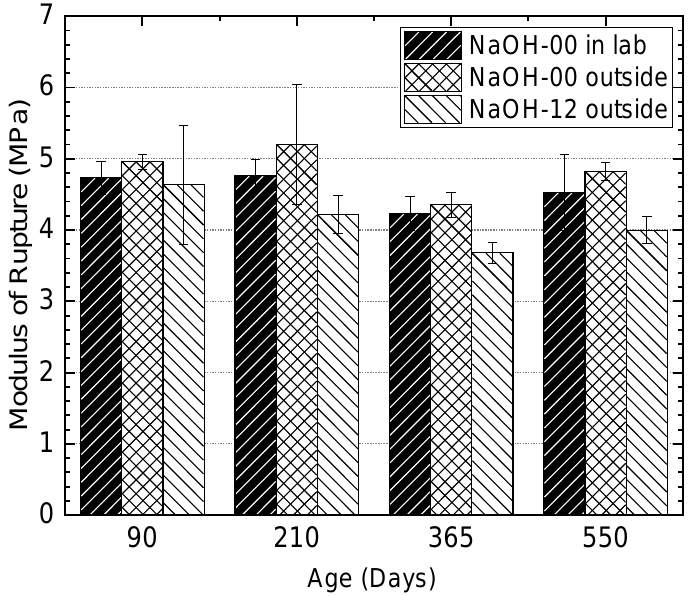
Figure 20. Effect of alkali addition on the modulus of rupture of concretes at different ages. Figure 20. E ff ect of alkali addition on the modulus of rupture of concretes at di ff erent